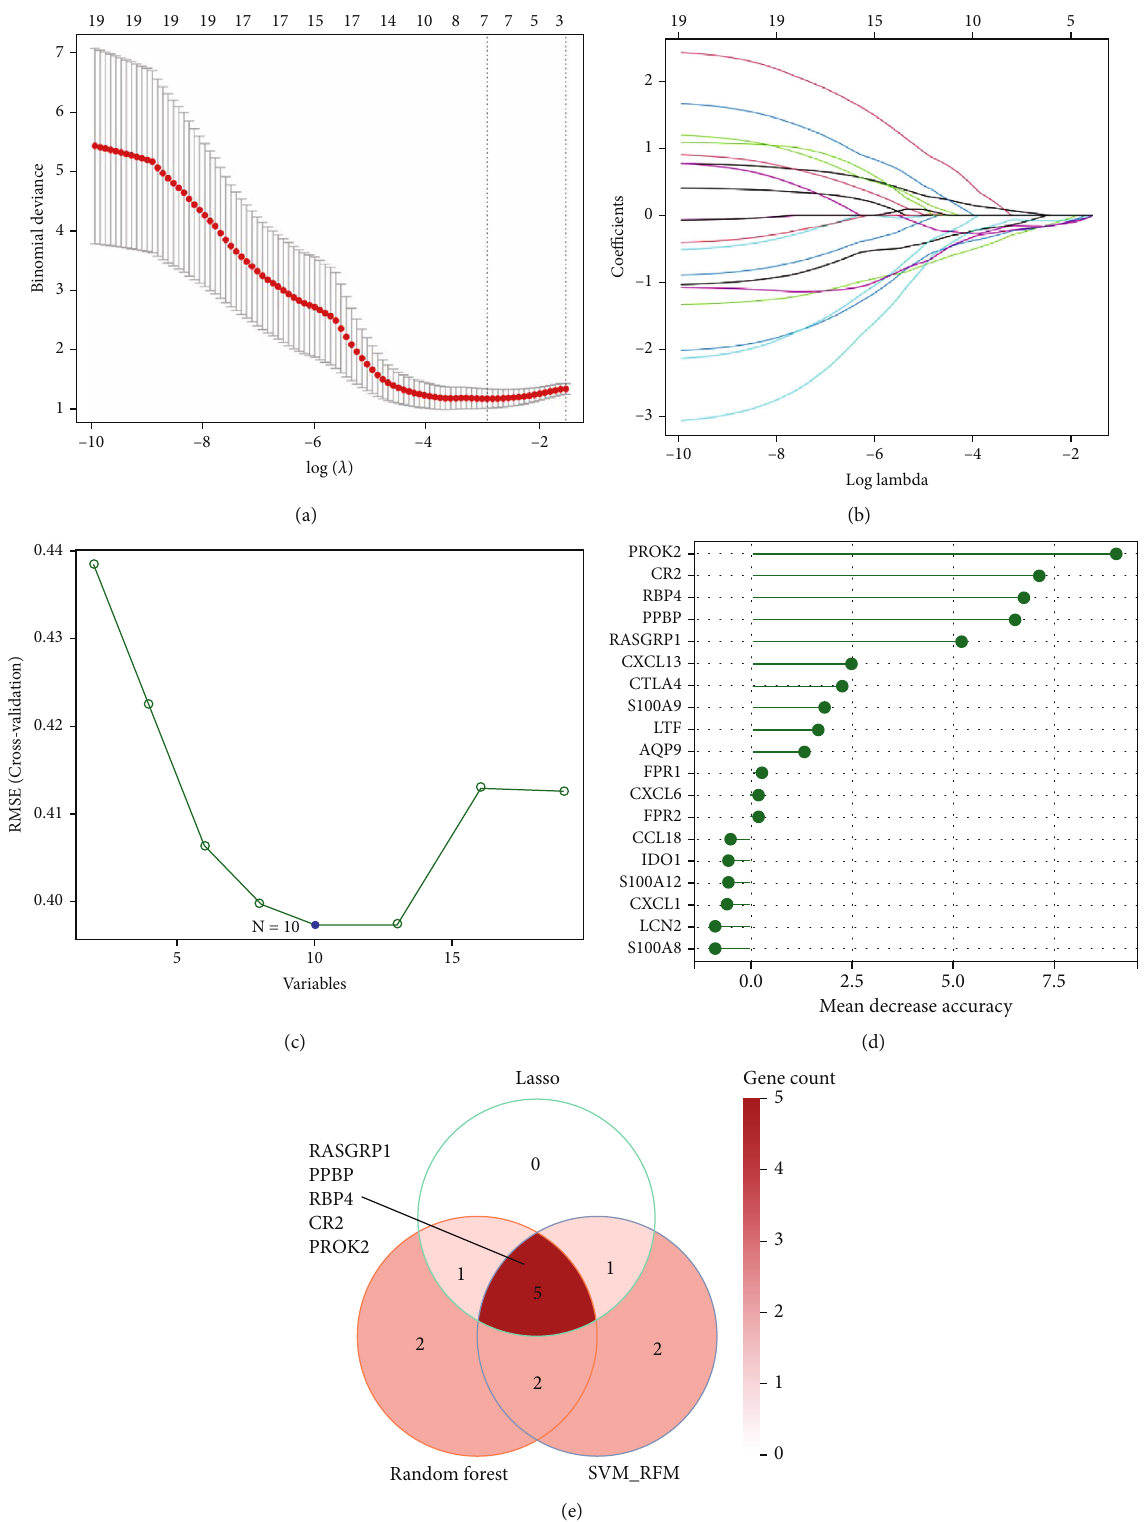
Figure 3: IC characteristic genes selected based on the integrative machine learning algorithms. (a, b) Identi fi cation of the IC characteristic genes using LASSO regression algorithm; the optimal lambda was determined as 0.053 after tenfold cross-validation. (c) Identi fi cation of the IC characteristic genes using SVM-RFE algorithm; the classi fi er showed the minimum error when N = 10 . (d) Identi fi cation of the IC characteristic genes using random forest algorithm; the bar plot shows the mean decrease accuracy of each gene; the top 10 most important genes were selected as characteristic genes. (e) The Venn diagram performs the fi ve most important IC characteristic